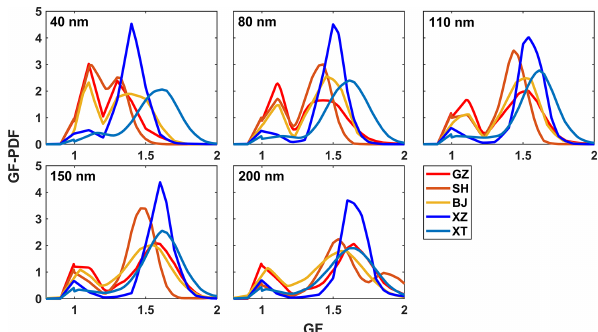
Figure 3. Mean probability density functions of growth factor (GF- PDFs) for different particle sizes (40–200nm) derived from H- TDMA data at different sampling